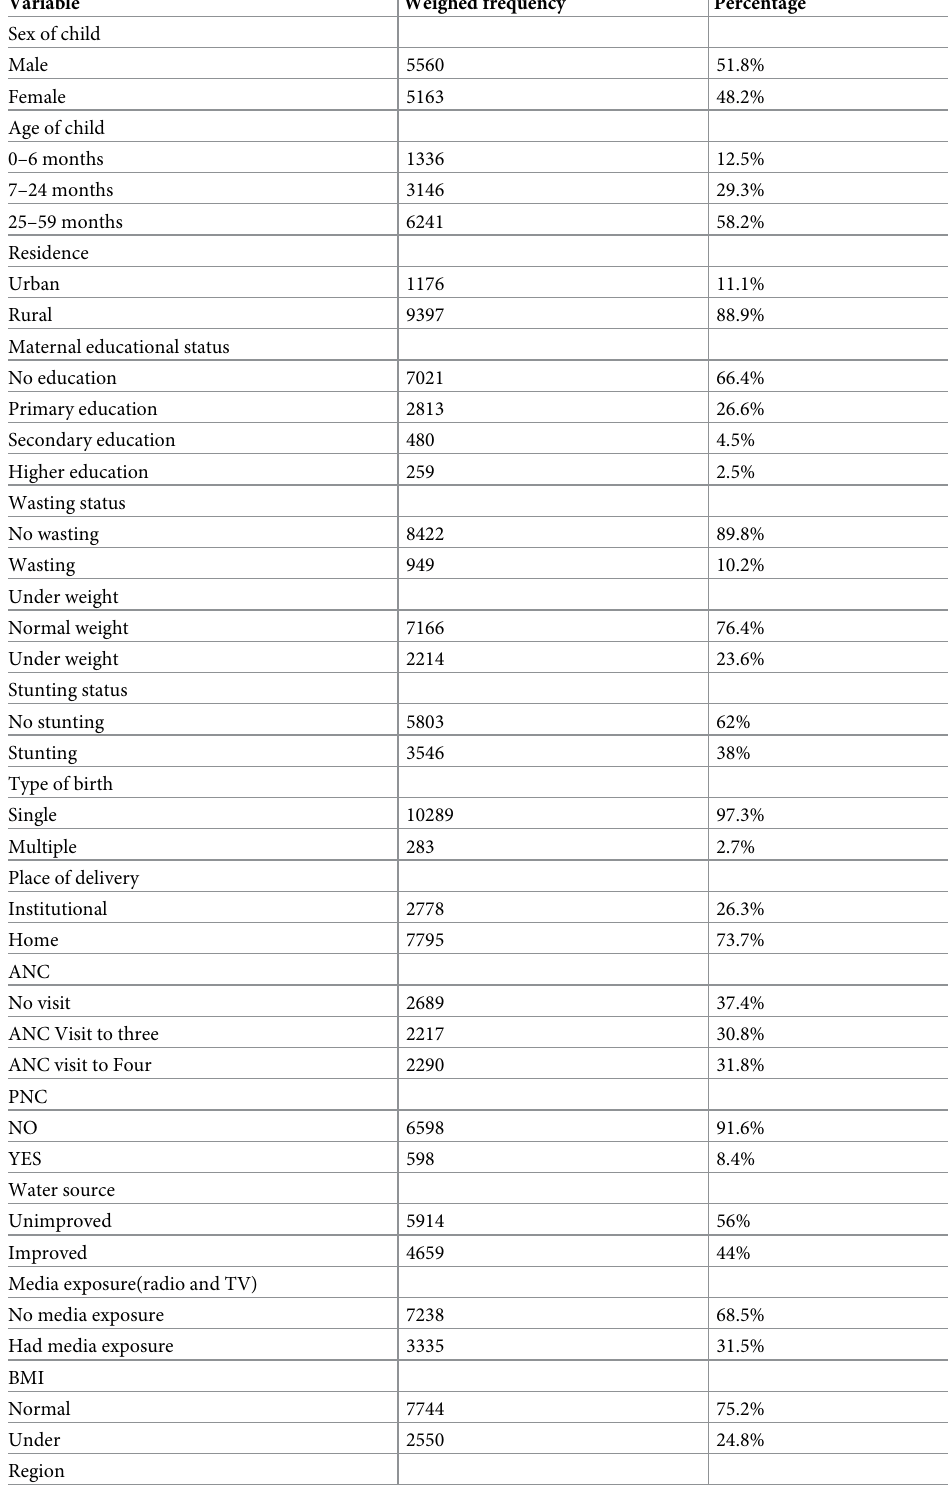
Table 1. Socio-demographic characteristics of the study participants in Ethiopia,